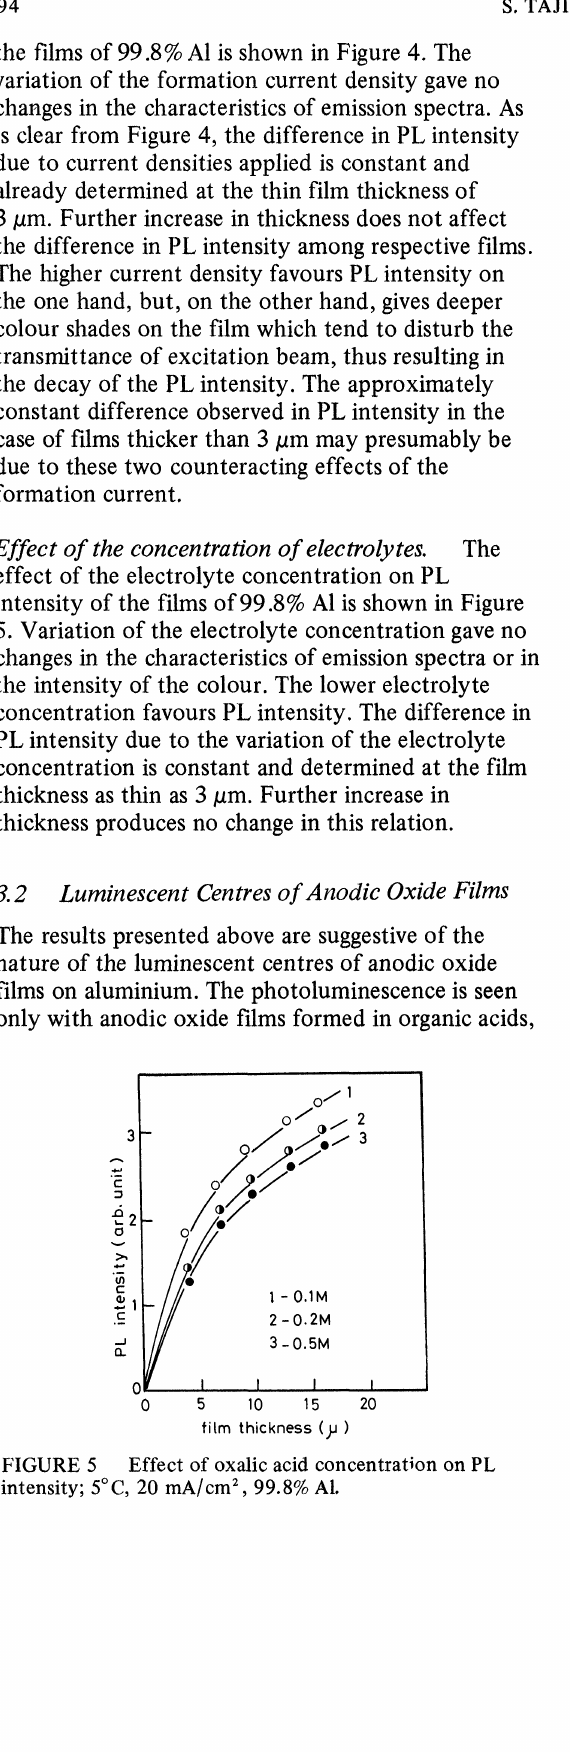
, Effect of oxalic acid concentration on PL 99.8% intensity; 5C, 20 mA/cm